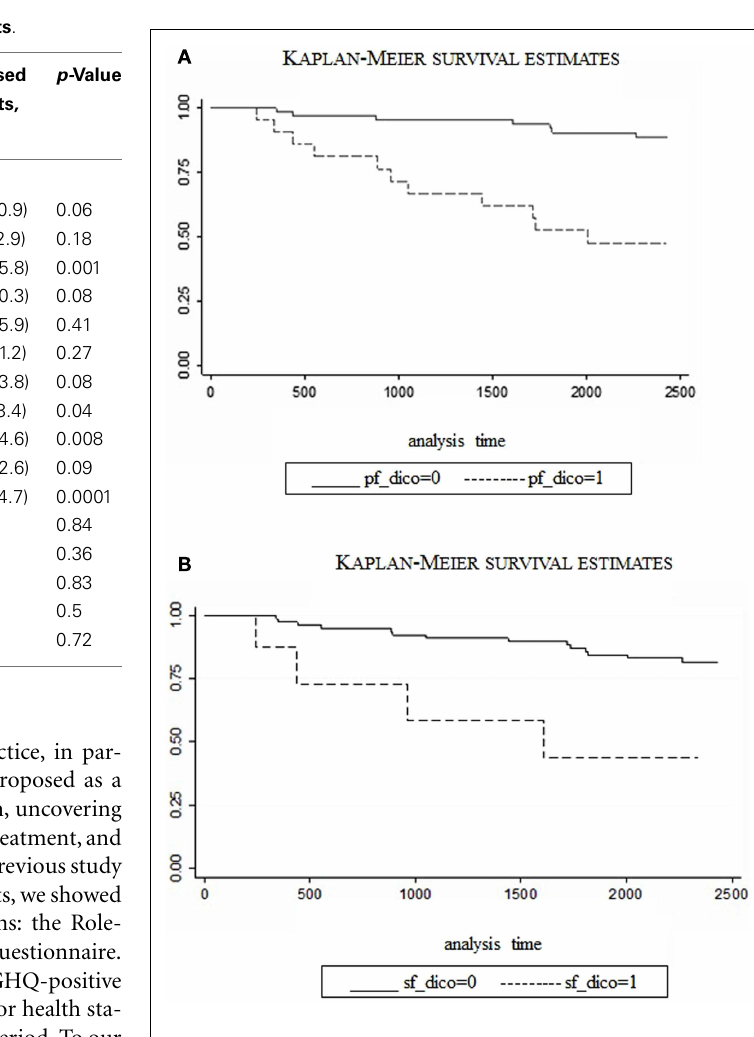
FIGURE 4 | Survival rates for CVID patients (“at-risk” vs. “not at-risk”) considering SF-36 scales: Physical Functioning, cut-off at 50 (A) and Social Functioning cut-off at 37.5 (B) . (dico: